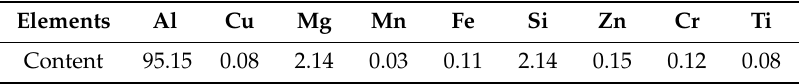
Table 2. Chemical composition of Al 6061 by X-ray fluorescence (wt.%).